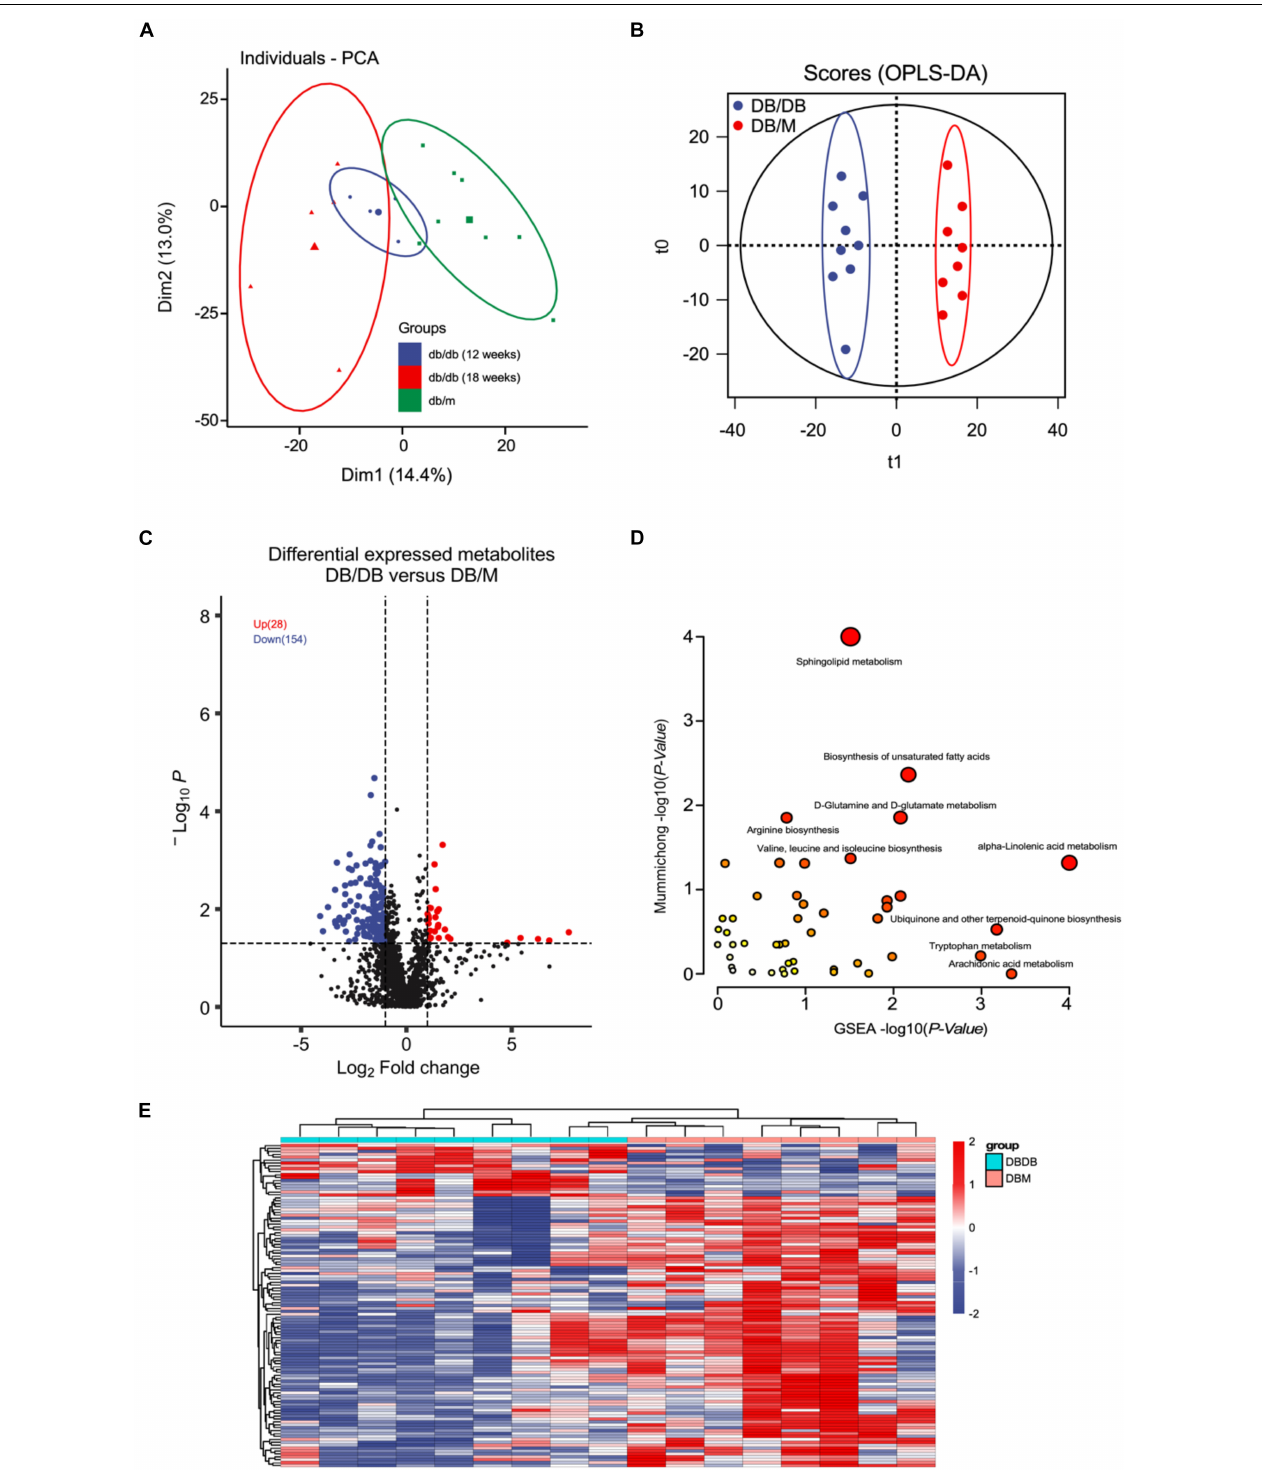
FIGURE 4 | Metabolomics analysis between kidneys of db/db and db/m mice. (A,B) PCA (A) and OPLS-DA (B) plots of the metabolites detected in kidneys of db/db and db/m mice (12 weeks db/db, n = 4; 18 weeks db/db, n = 5; db/m, n = 8). (C) Volcano plot showing the DEMs between kidneys of db/db and db/m mice. (D) The bubble plot showing the enriched KEGG pathways of DEMs between kidneys of db/db and db/m mice. (E) The heatmap illustrating the levels of DEMs in kidneys of db/db and db/m mice, each row represents one protein, each column represents one sample.